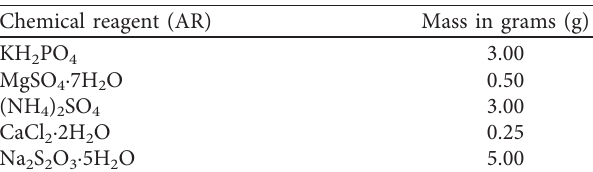
Table 2: Composition for the Acidithiobacillus thiooxidans me- dium (DSM